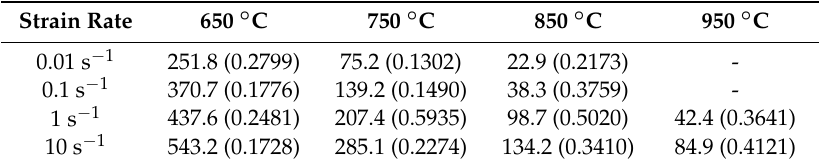
Table 3. Critical stress (MPa) and corresponding strain of the Fe-6.5wt. %Si alloy.